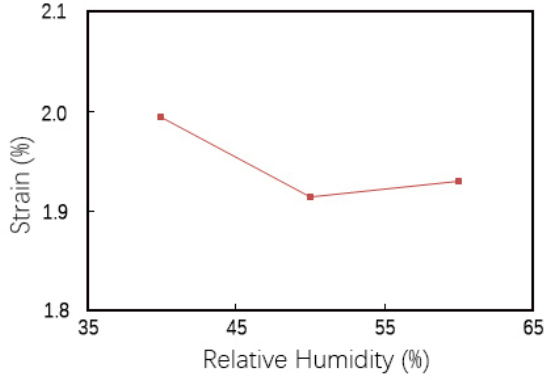
Figure 7. Effect of humidity on the creep strain of the